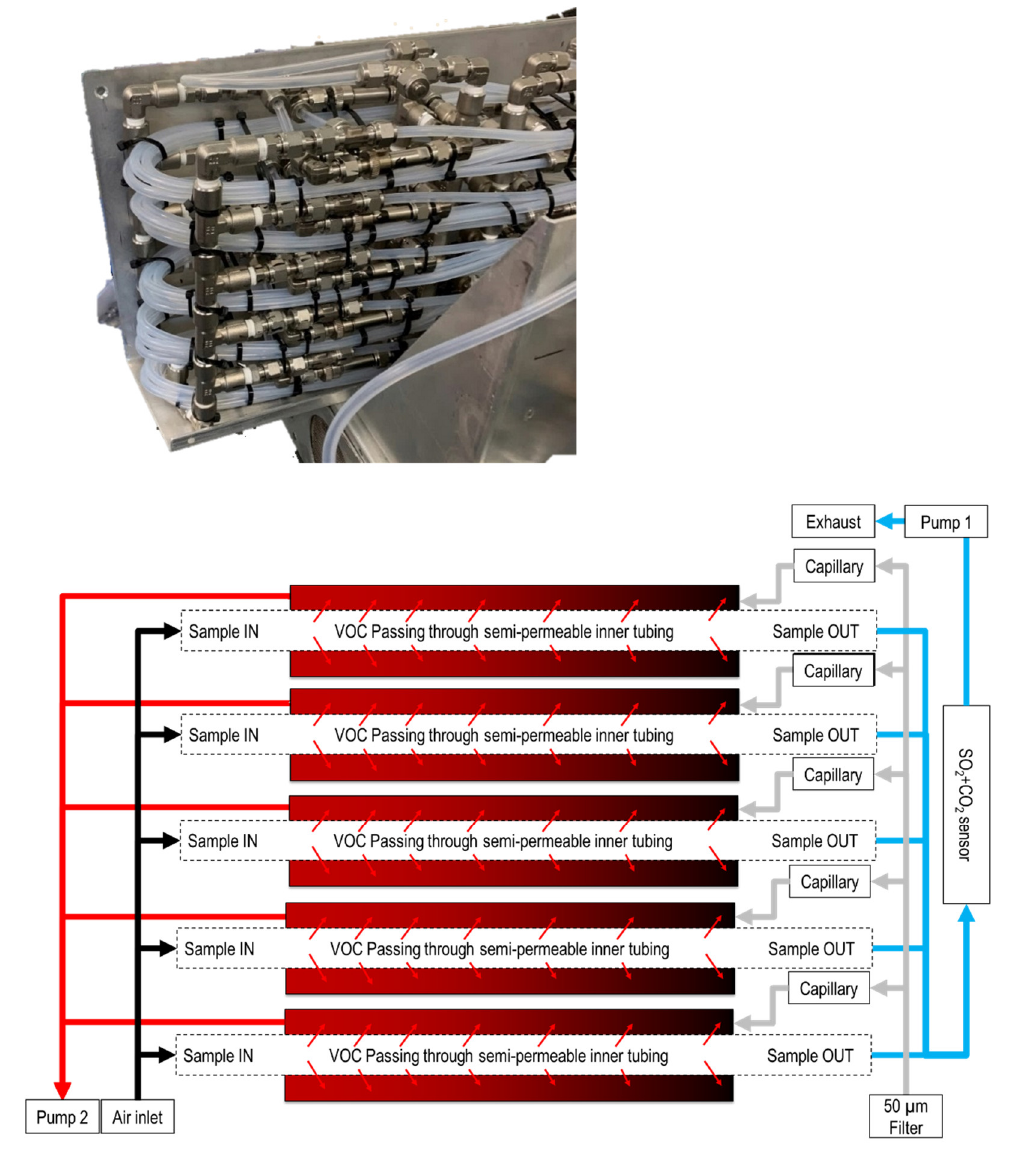
Figure 2. Upper: Picture of the high-volume HC kicker designed to fit the sniffer sensor system. The kicker is composed of ten standard low-volume HC kickers that are connected in parallel creating the high-volume HC kickers in five levels, with two low-volume HC kickers per level. Lower: Scheme of the working mechanism of the HC kicker, which shows only the five levels of one side of the high-volume HC kicker. The air inlet containing VOCs (black line) goes into the inner compartment. A clean (gray) low-pressure airflow flows in the opposite direction in the outer compartment. VOCs pass through the semi-permeable wall and are removed from the airflow that goes to the Thermo 43i TLE and Licor-7200 RS sensors (blue lines). The VOCs are evacuated via the outflow of the outer compartment (red line) to the exhaust of the sniffer